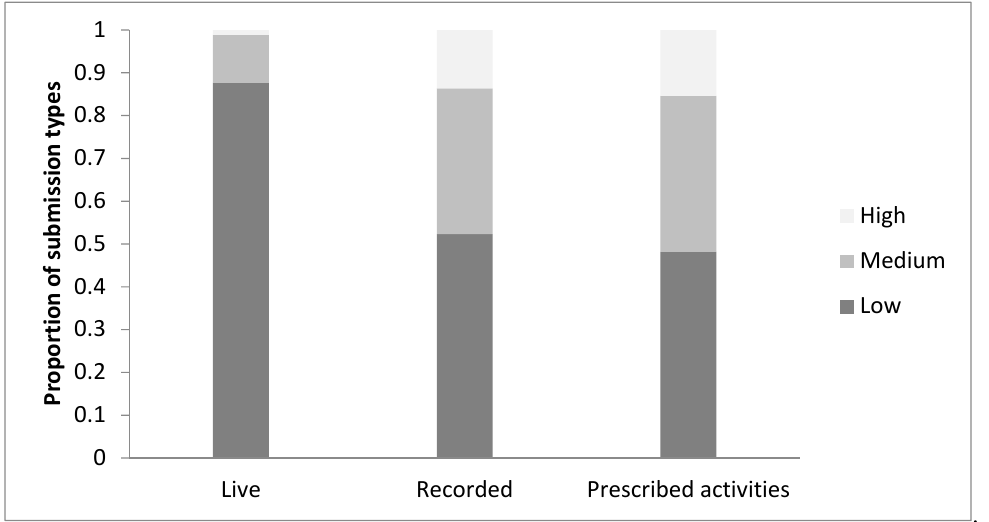
Figure 2. Proportion of submissions by activity type and coded level of complexity (low/medium and high).